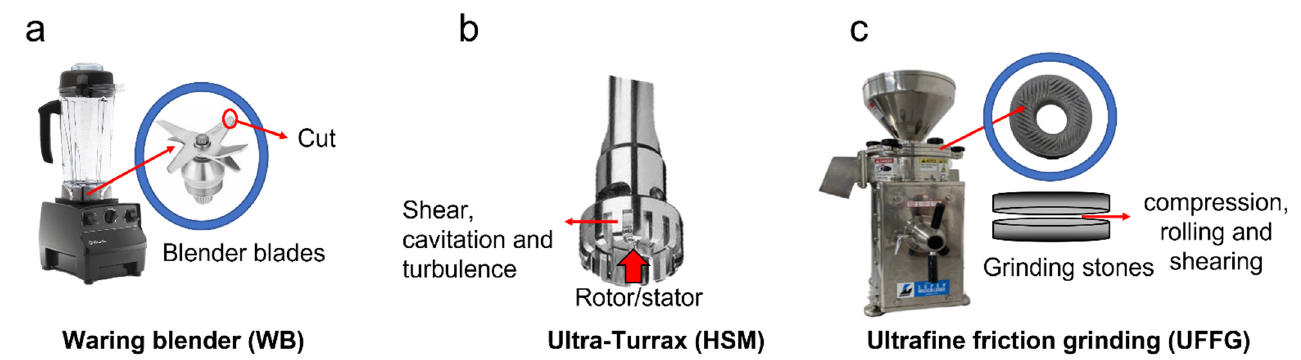
Figure 6. Photographs of the equipment used for mechanical treatment: ( a ) waring blender (WB),